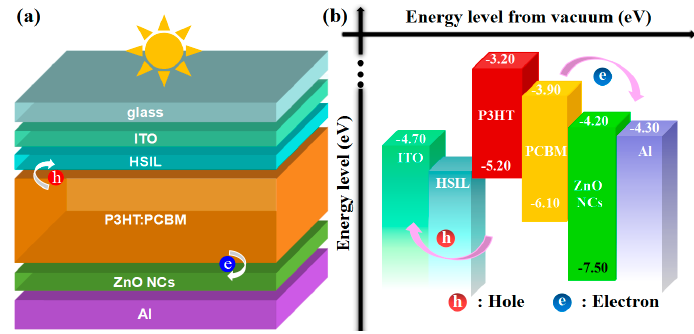
Figure 1. ( a ) Conventional architecture and ( b ) energy levels of compositions in BHJ-PSC.